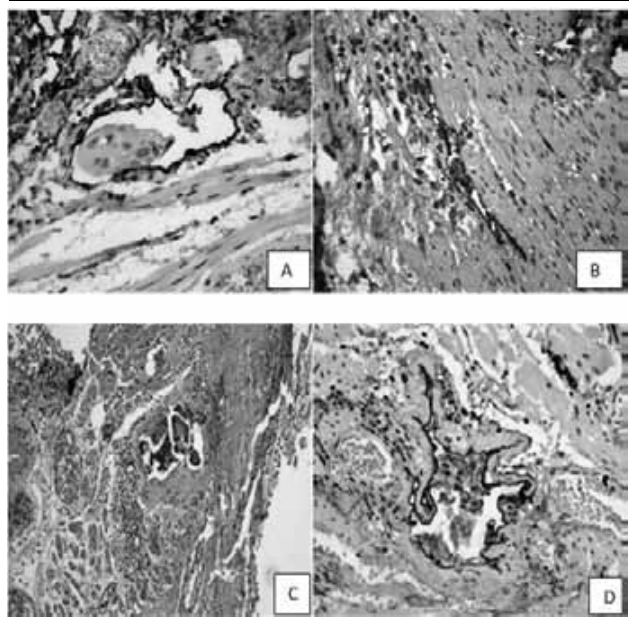
figurE – Photomicrographs of LVI detected only by IHC and false vascular invasion diagnosed by HE A and B: LVI (immunostaining by D2 dial-40 [400×]), C: false LVI (HE, 400×); D: false LVI (immunostaining by D2 dial-40